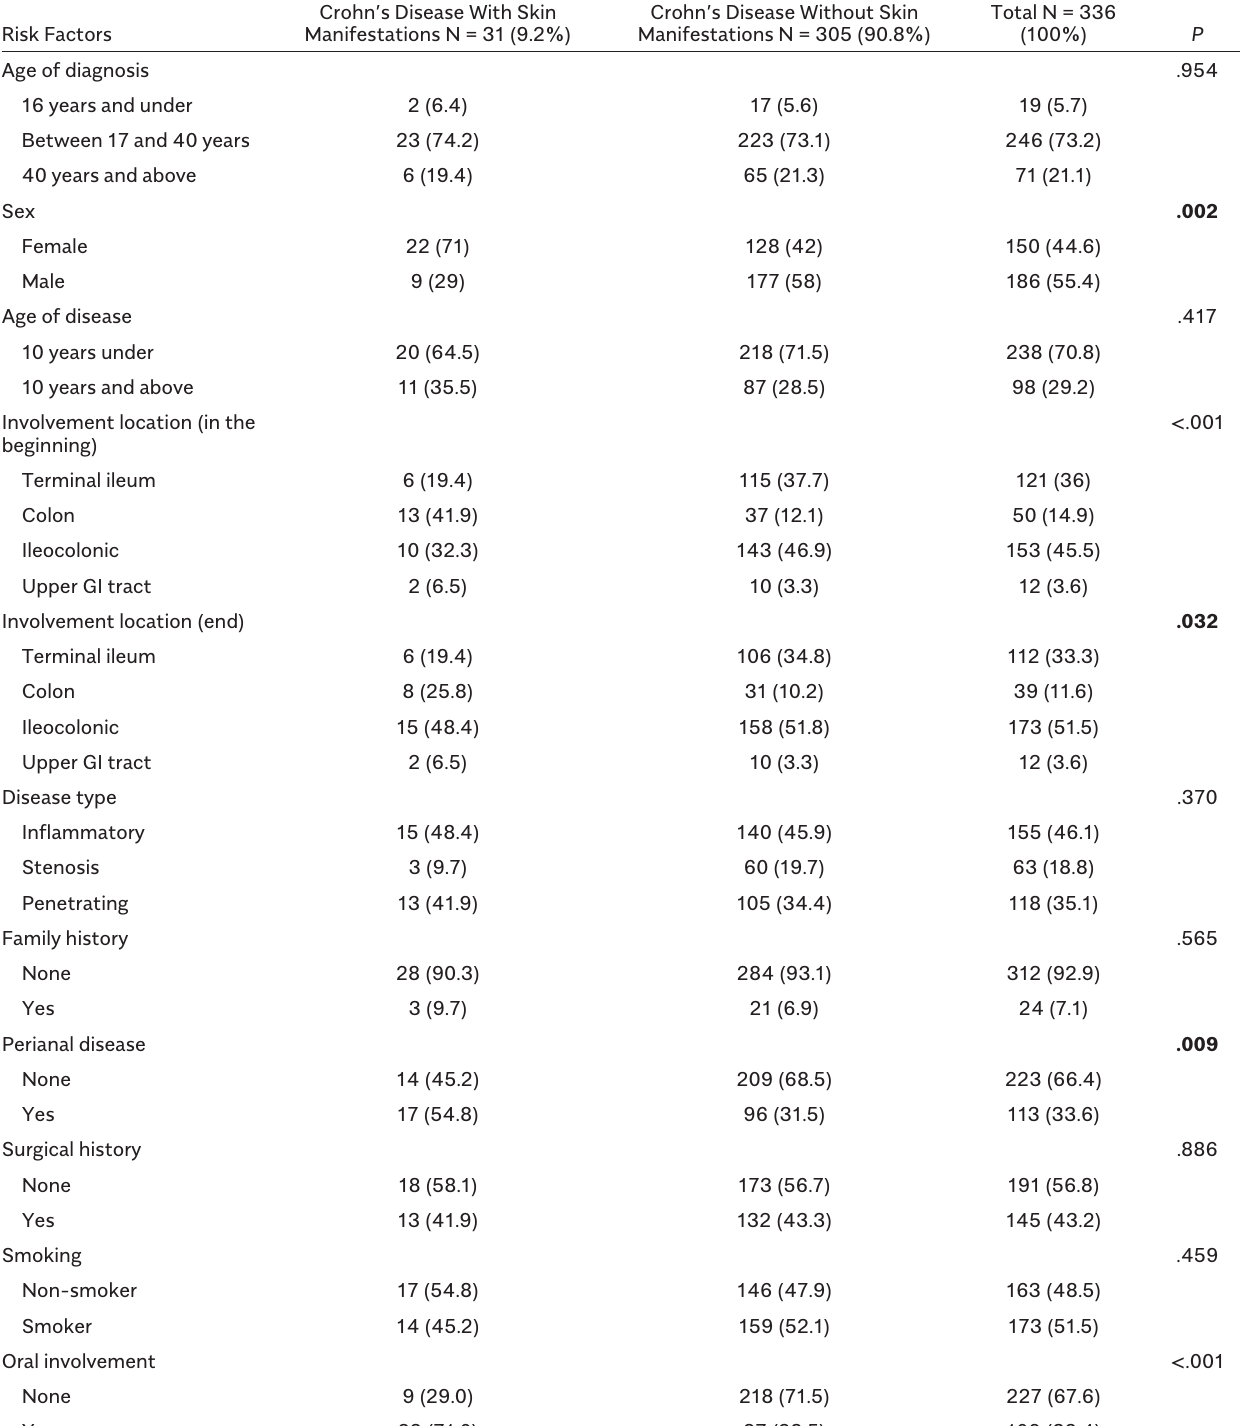
Table 1. The Relationship Between Skin Manifestations and Risk Factors in Patients with Crohn’s Disease Crohn’s Disease With Skin Crohn’s Disease Without Skin Risk Factors Manifestations N = 31 (9.2%) Manifestations N = 305